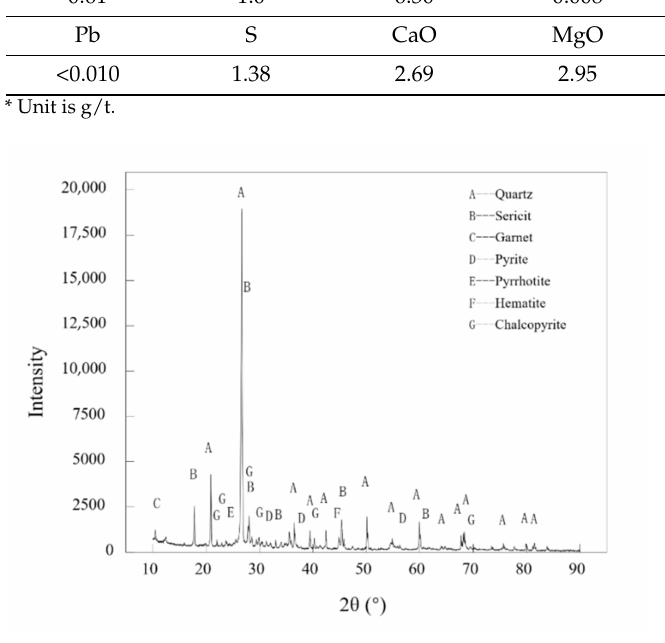
Figure 2. XRD patterns of the